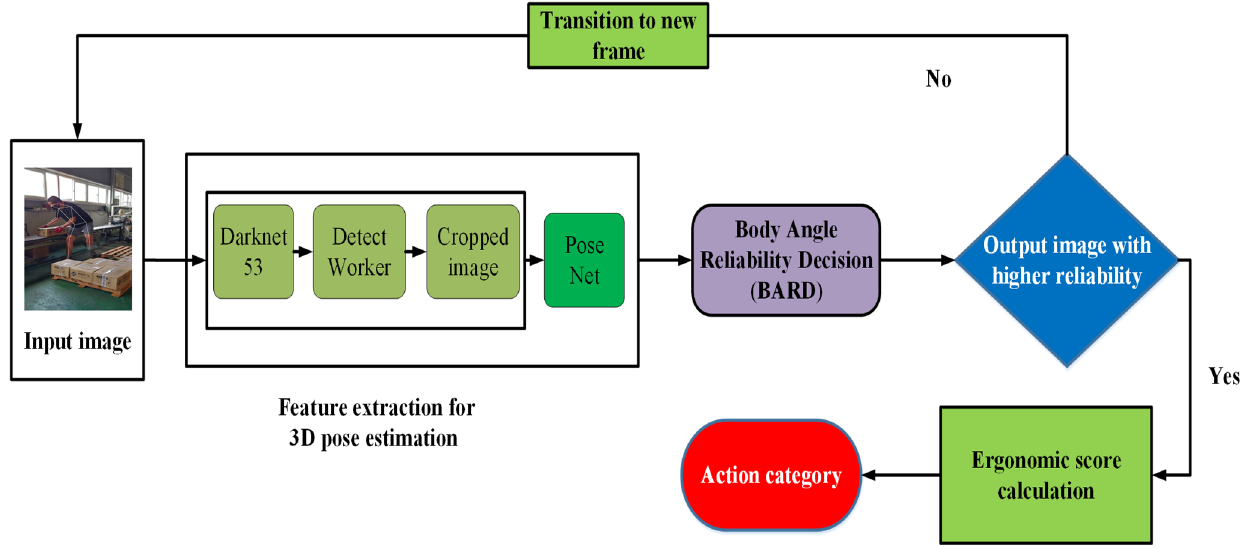
Figure 2. Pipeline of proposed architecture and BARD for workers’ pose estimation and action cat- egory.